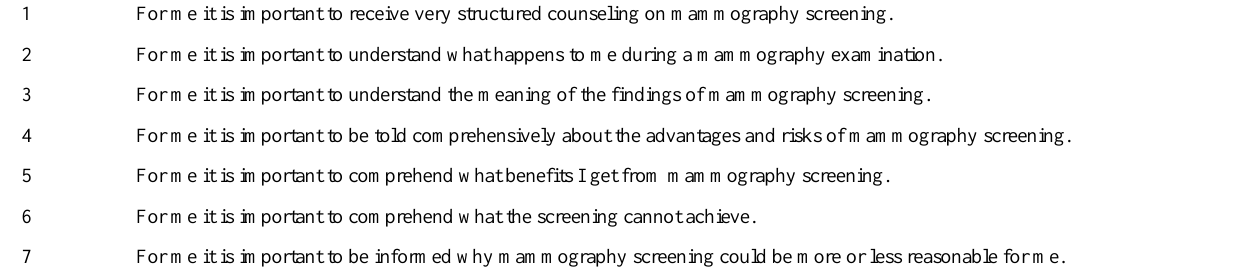
Table 3. Need for clarity scale.